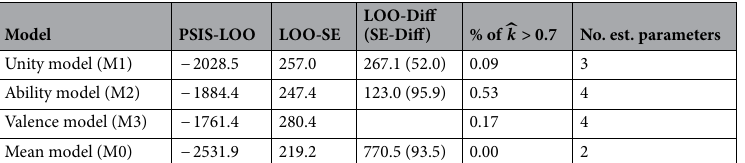
(cid:31) k —estimated